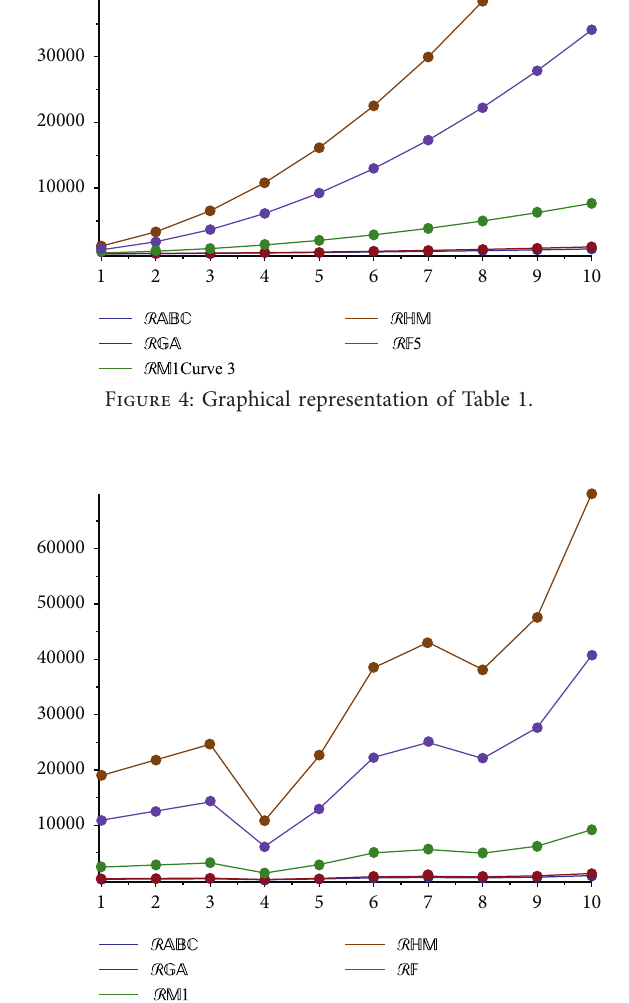
Figure 5: Graphical representation of Table